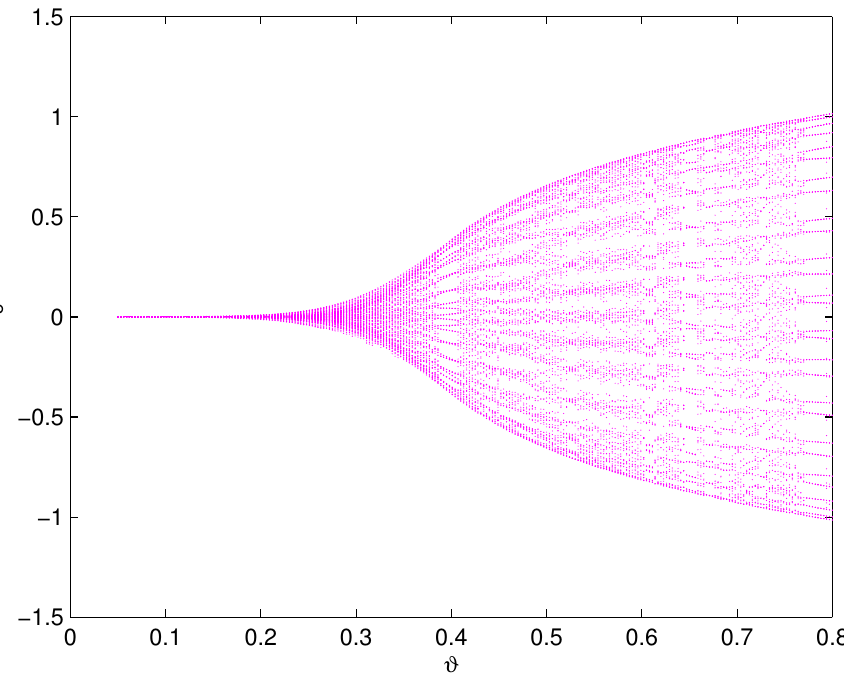
Figure 7. Bifurcation graph of system (71): the delay ϑ versus the variable w 5 . The bifurcation number is